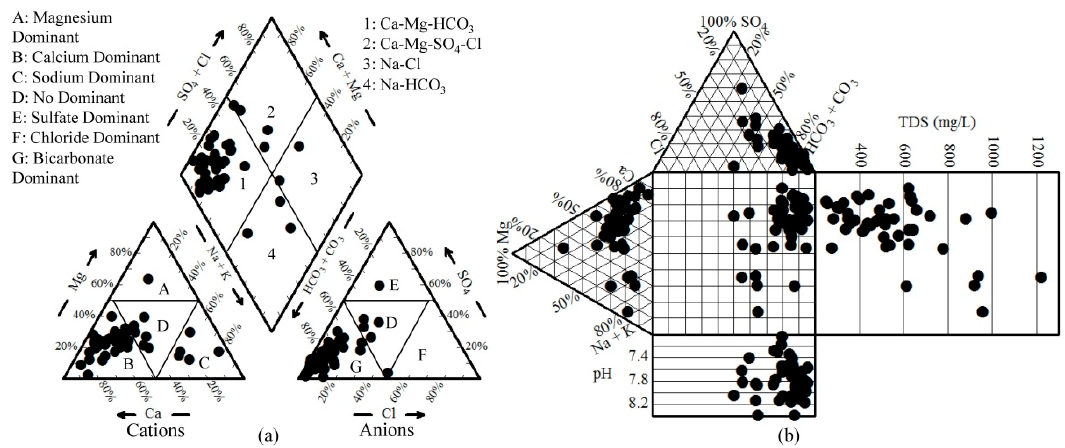
Figure 4. Piper ( a ) and Durov ( b ) diagrams showing the samples classifications.